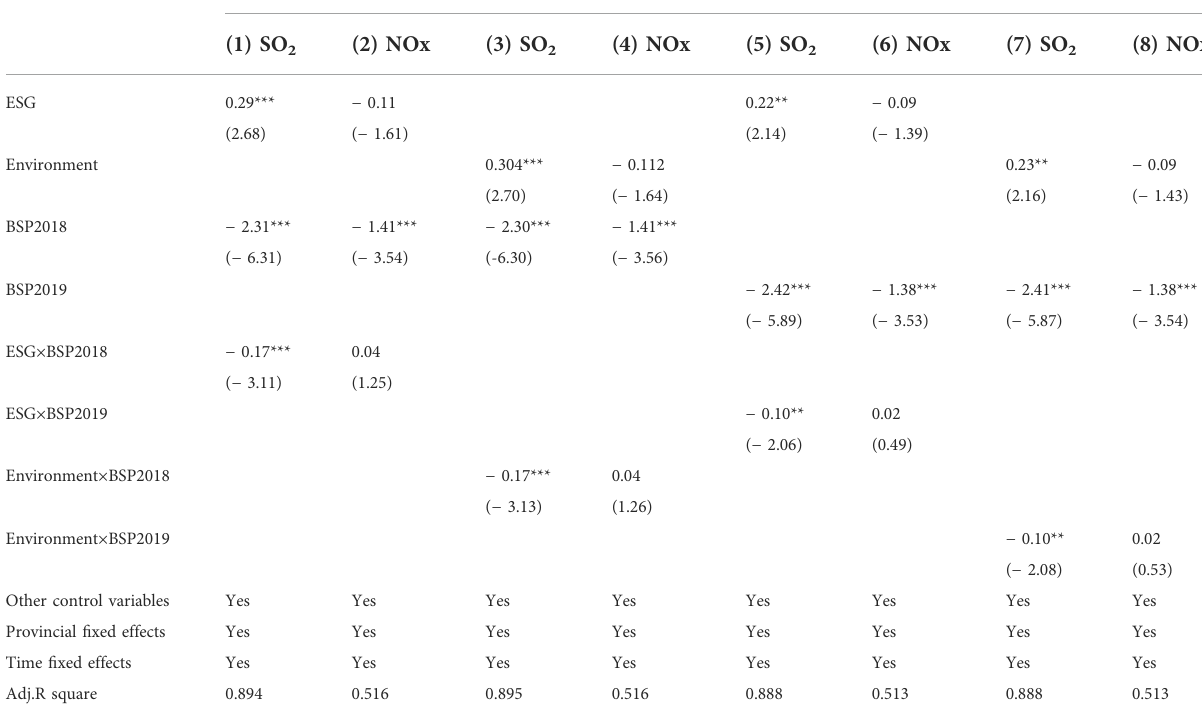
TABLE 5 Provincial-level policy effects of the “ Blue Sky Plan ” on air pollutants emissions. Dependent